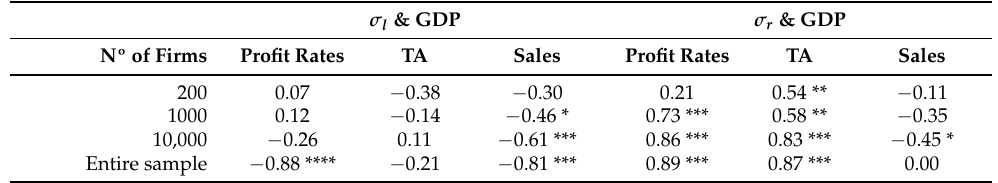
Figure 11. Estimates of the two shape parameters ( α l and α r ) and two scale parameters ( σ l and σ r ) of the AEP distribution for growth rates of sales conditional on size. Error bars show two standard errors. Gray and black dashed lines refer to the median of the estimates of σ l and σ r , respectively. Table 8. Pearson correlation coefficient between the time series of the estimates of σ l and σ r with the time series of GDP growth rates. *** denotes significance at the 1% level; ** denotes significance at the 5% level; * denotes significance at the 10%